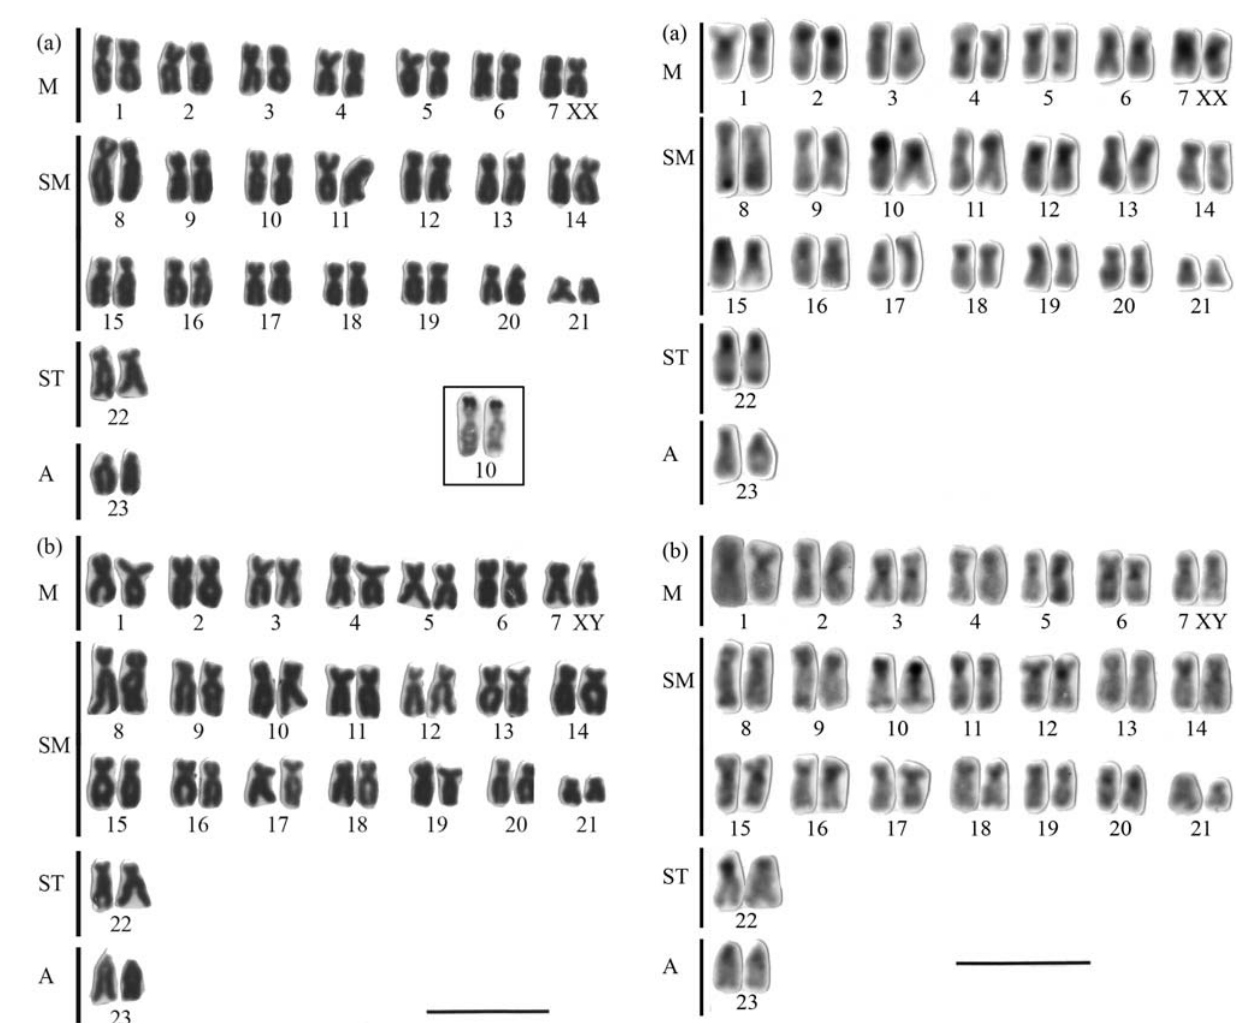
Figure 1 - Giemsa stained karyotypes of Dormitator maculatus . (a) Fe- male;(b)Male.TheAg-NOR-bearingchromosomepairisshoneinthein-